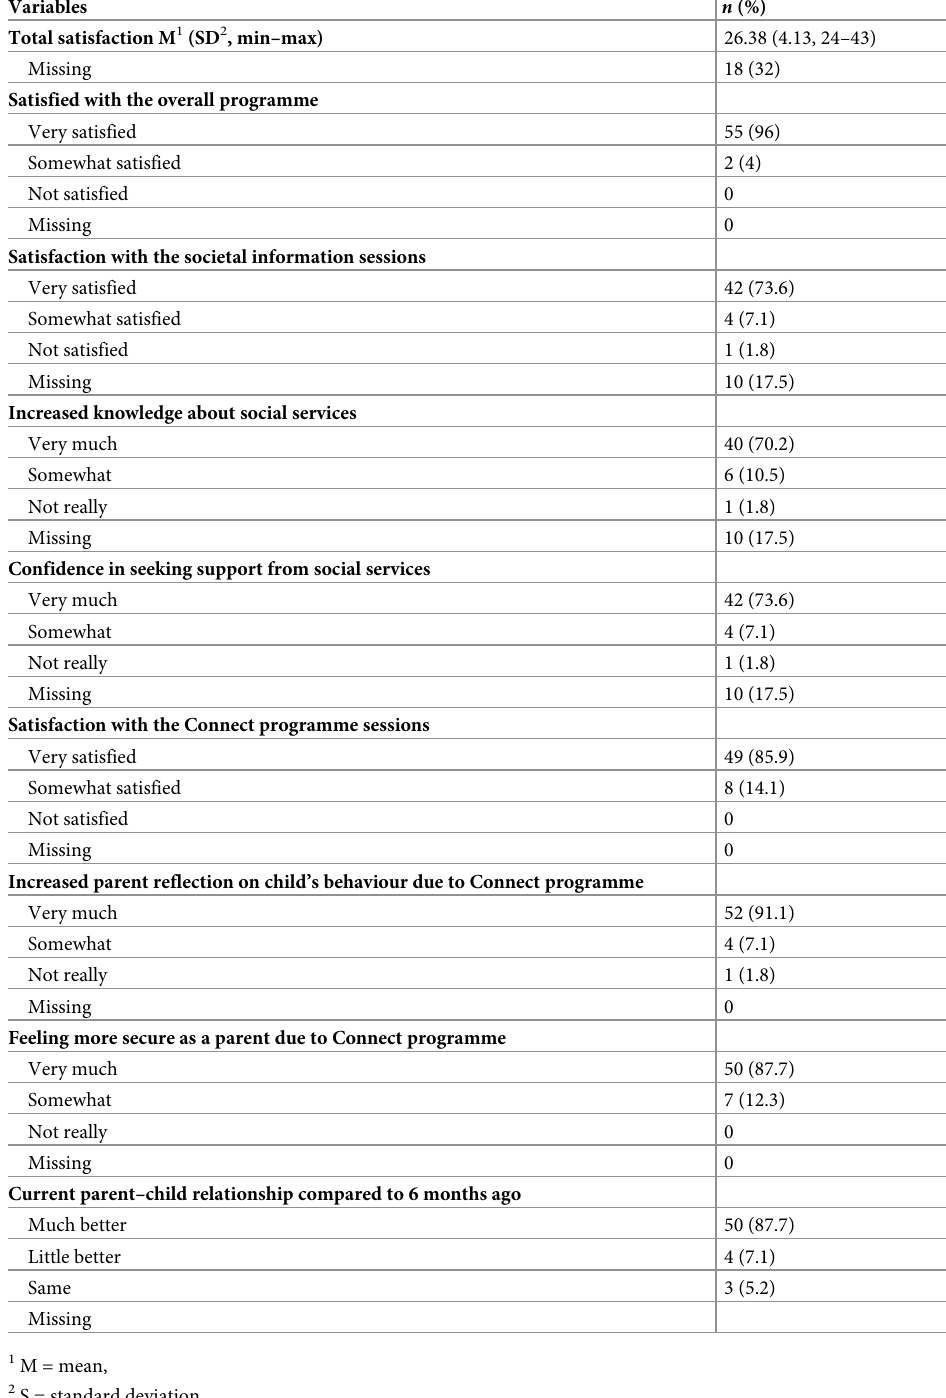
Table 6. Parent satisfaction with the programme according to the Client Satisfaction Questionnaire (CSQ) ( n = 57).